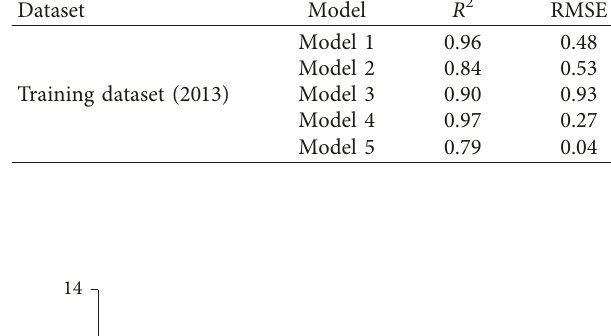
Table 6: Results of the proposed models for training dataset. Dataset